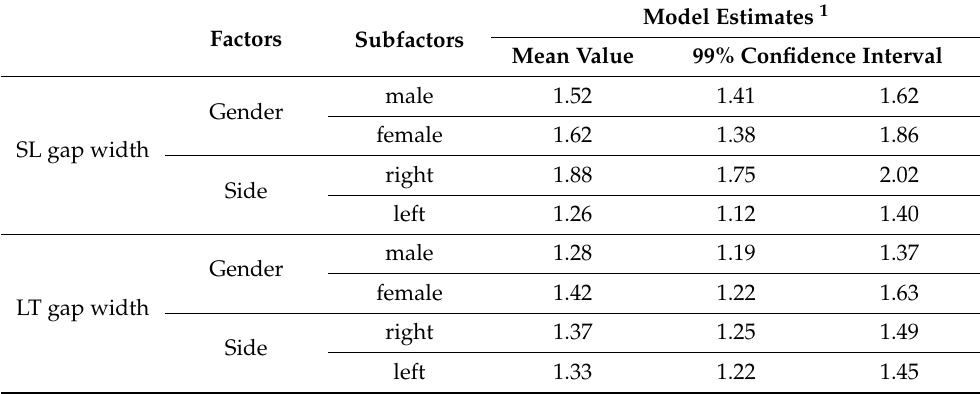
Figure 6. Consecutive still images of a left wrist across the entire range of active radioulnar movement that ranged from maximum radial abduction to maximum ulnar abduction ( A – H ). The carpus and forearm are color-coded as in Figure 2 and overlaid onto the morphologic images. Inset (lower left) are the resultant wrist angles (“angle”), LT gap width (“LT”), and SL gap width (“SL”). The corresponding video that visualizes fluent movement across the entire range-of-motion is appended as Video S1. Table 3. Estimated mean values of scapholunate (SL) and lunotriquetral (LT) gap widths (mm) as a function of gender and side based on a linear mixed model. The model included the fixed effects gender and side as well as the covariates wrist angle, height, and age. For the calculation, 16,800 real-time MR images of 56 wrists (28 healthy volunteers) were included.